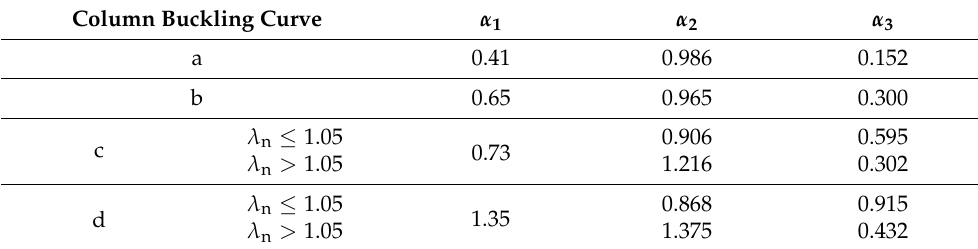
Column Buckling